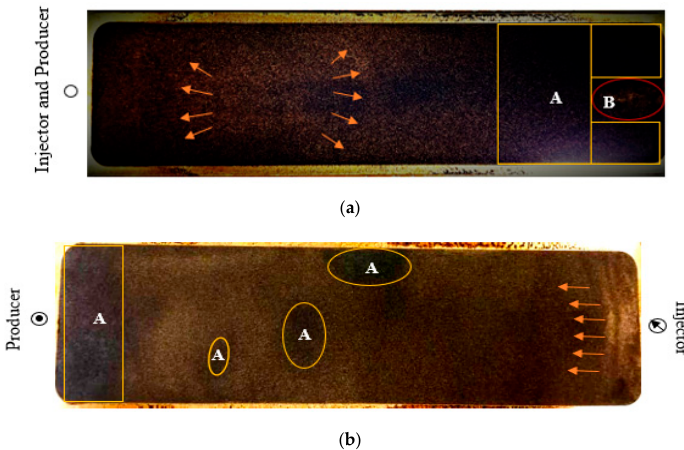
Figure 11. ( a ) A digital photo of the 2-D physical model after the CSI process was completed, which shows the directions of the back-and-forth movements of the foamy oil, Region A, where the heavy oil had regained its viscosity, and Region B, where some solvent was trapped. ( b ) A digital photo of the 2-D physical model after the GPC process was completed, which shows the direction of the foamy- oil displacement and the regions where the heavy oil was bypassed.